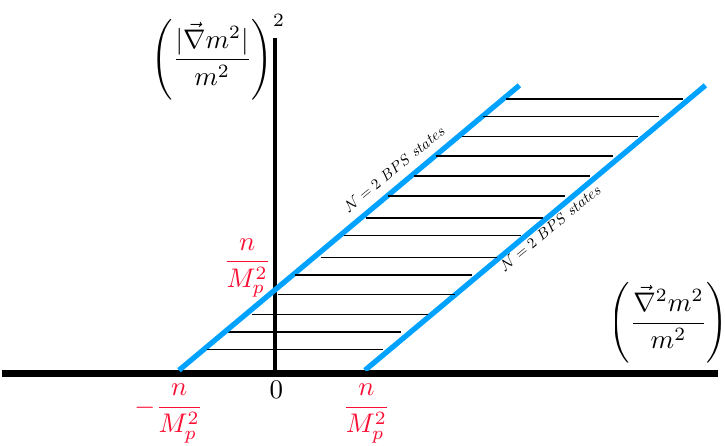
Figure 5 . The scalar WGC for n active moduli coupling to massive WGC scalars. The barred region correspond to points in moduli space in which gravity is too strong. This region disappears as M p → ∞ . N = 2 BPS states lie on top of the blue boundary